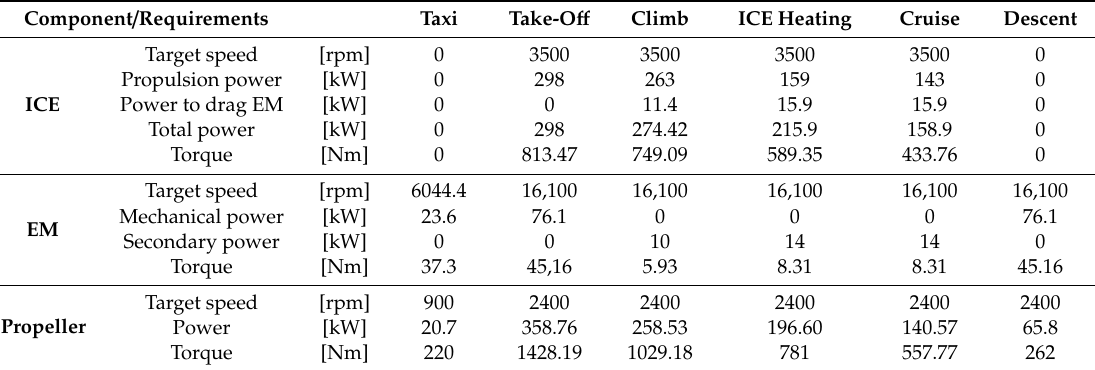
Table 3. Requirements for the real and the virtual test bench.